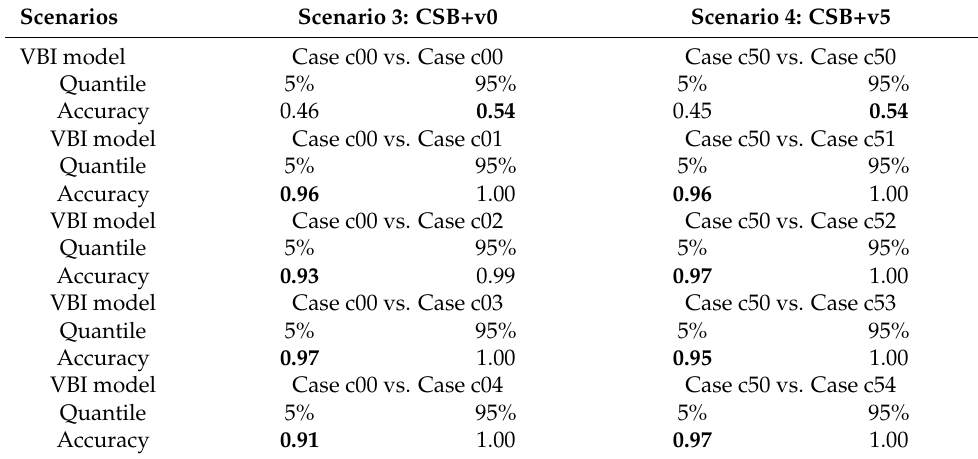
Table 12. Quantiles of accuracy values using MFCCs for